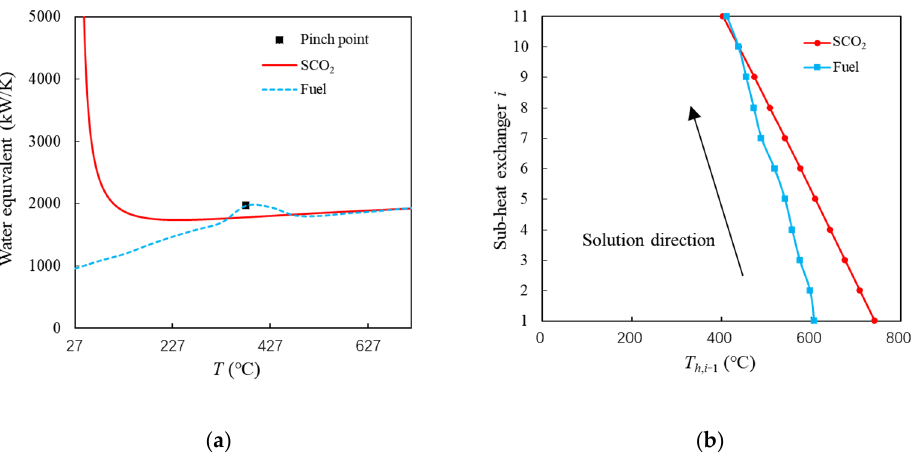
Figure 7. Heat exchange process of example point. ( a ) Variation curve of water equivalent with the temperature. ( b ) Temperature variation curve of sub-heat exchanger.